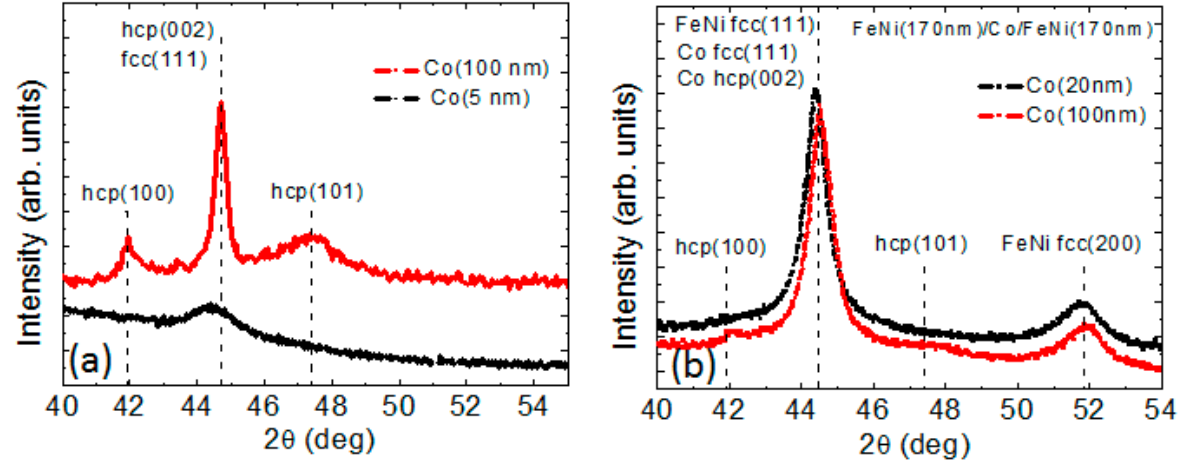
Figure 4. X-ray diffraction patterns for Co films of different thicknesses ( a ) and FeNi(170 nm)/Co(l Co )/FeNi(170 nm) trilayers ( b ). In all cases, the legends indicate the cobalt layer thickness.